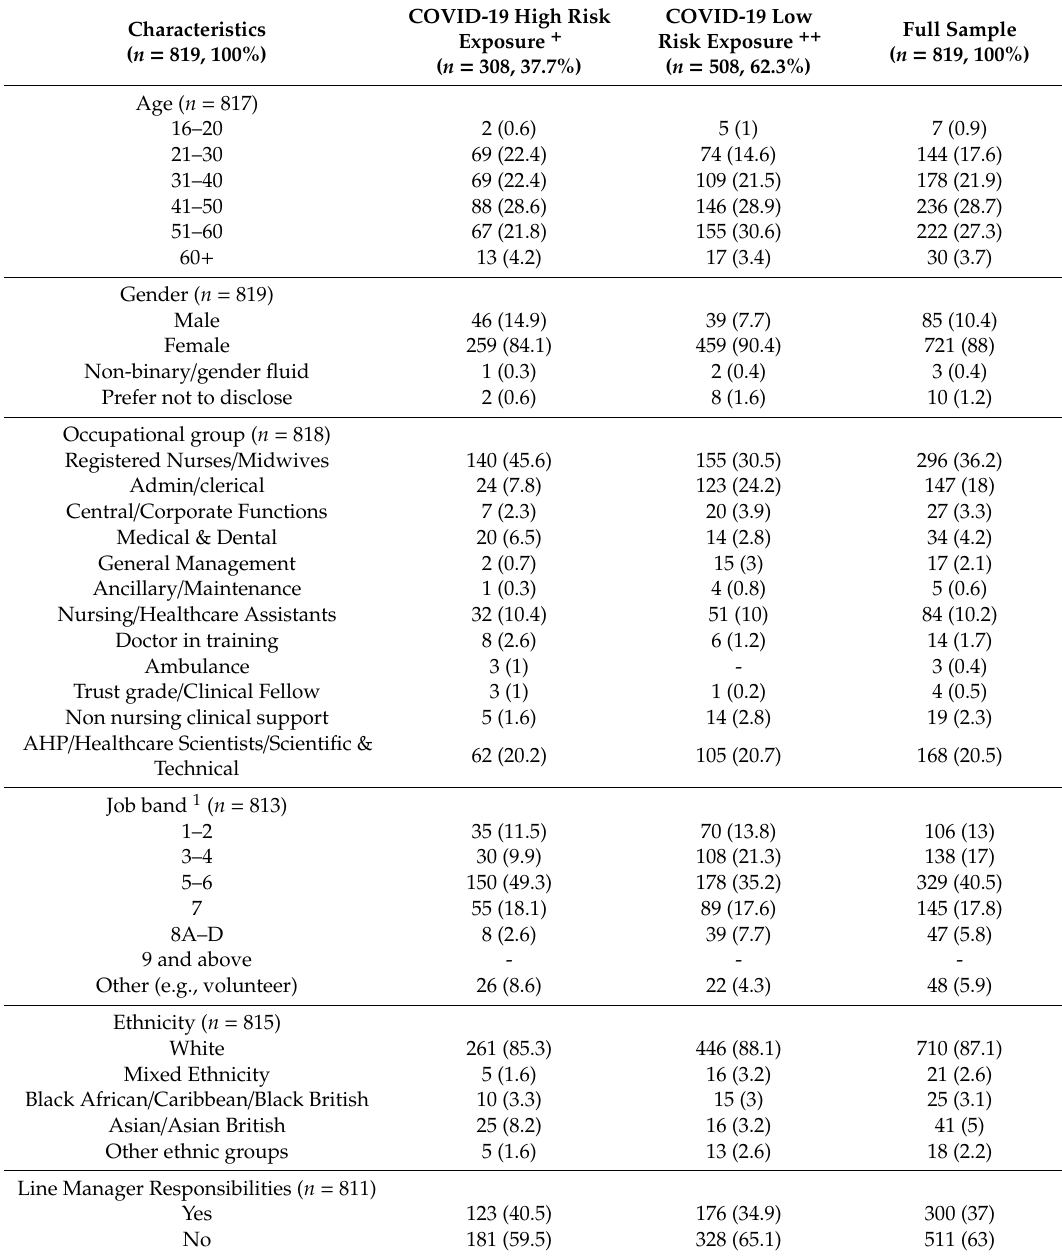
Table 2. Participant Characteristics by COVID-19 risk